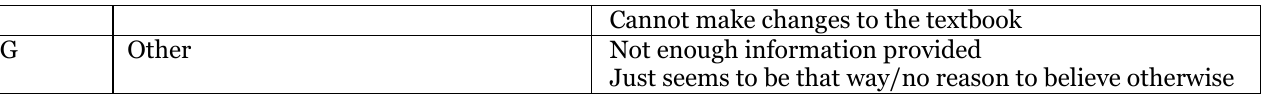
Tally of Responses Broken Down by Question